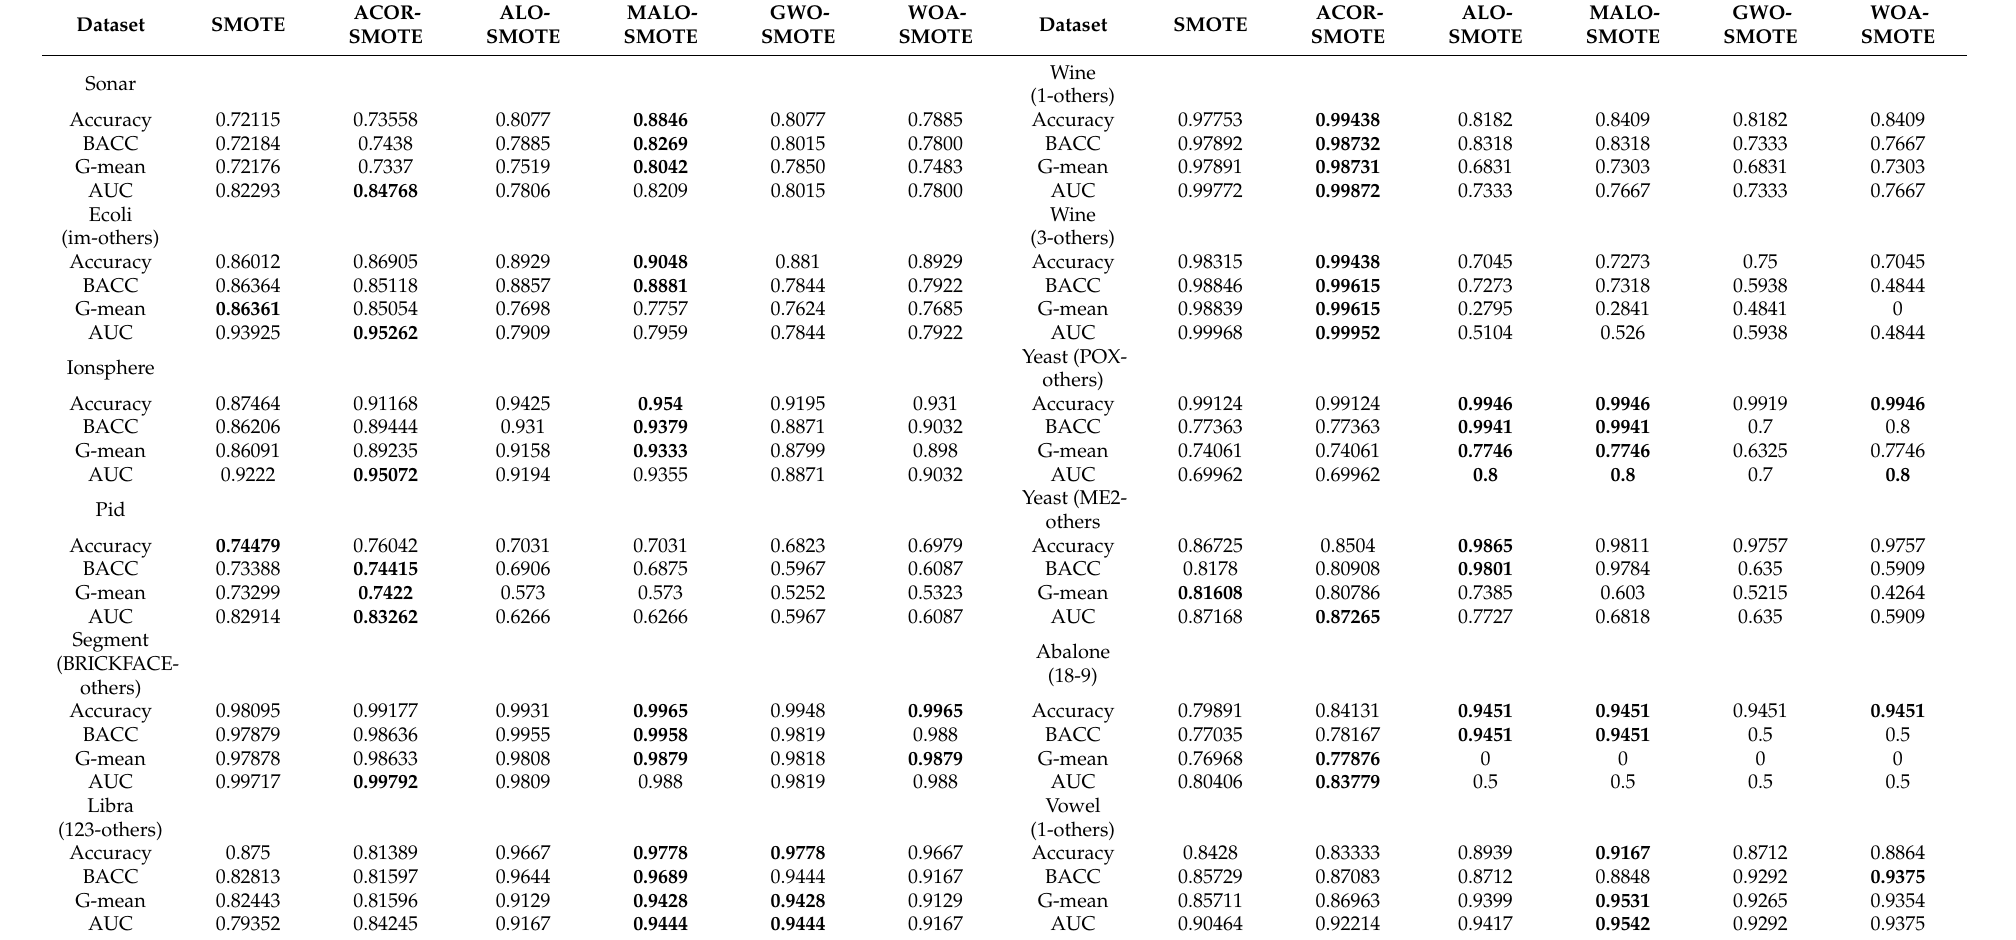
Table 18. Performances of smote and results in [51] compared to performances of ALO-SMOTE, MALO-SMOTE, GWO-SMOTE, and